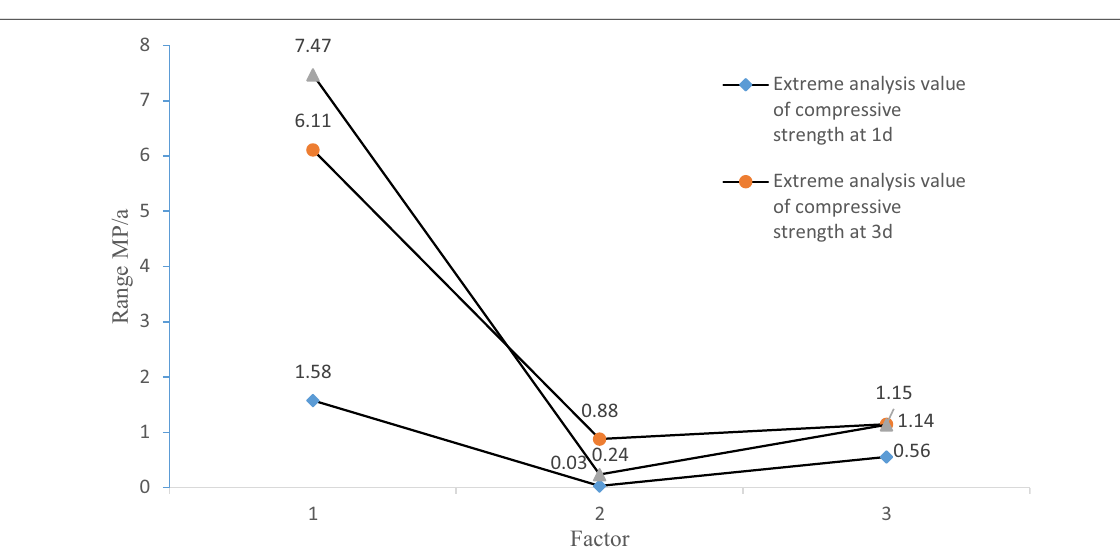
Fig. 4 Analysis value of each compressive